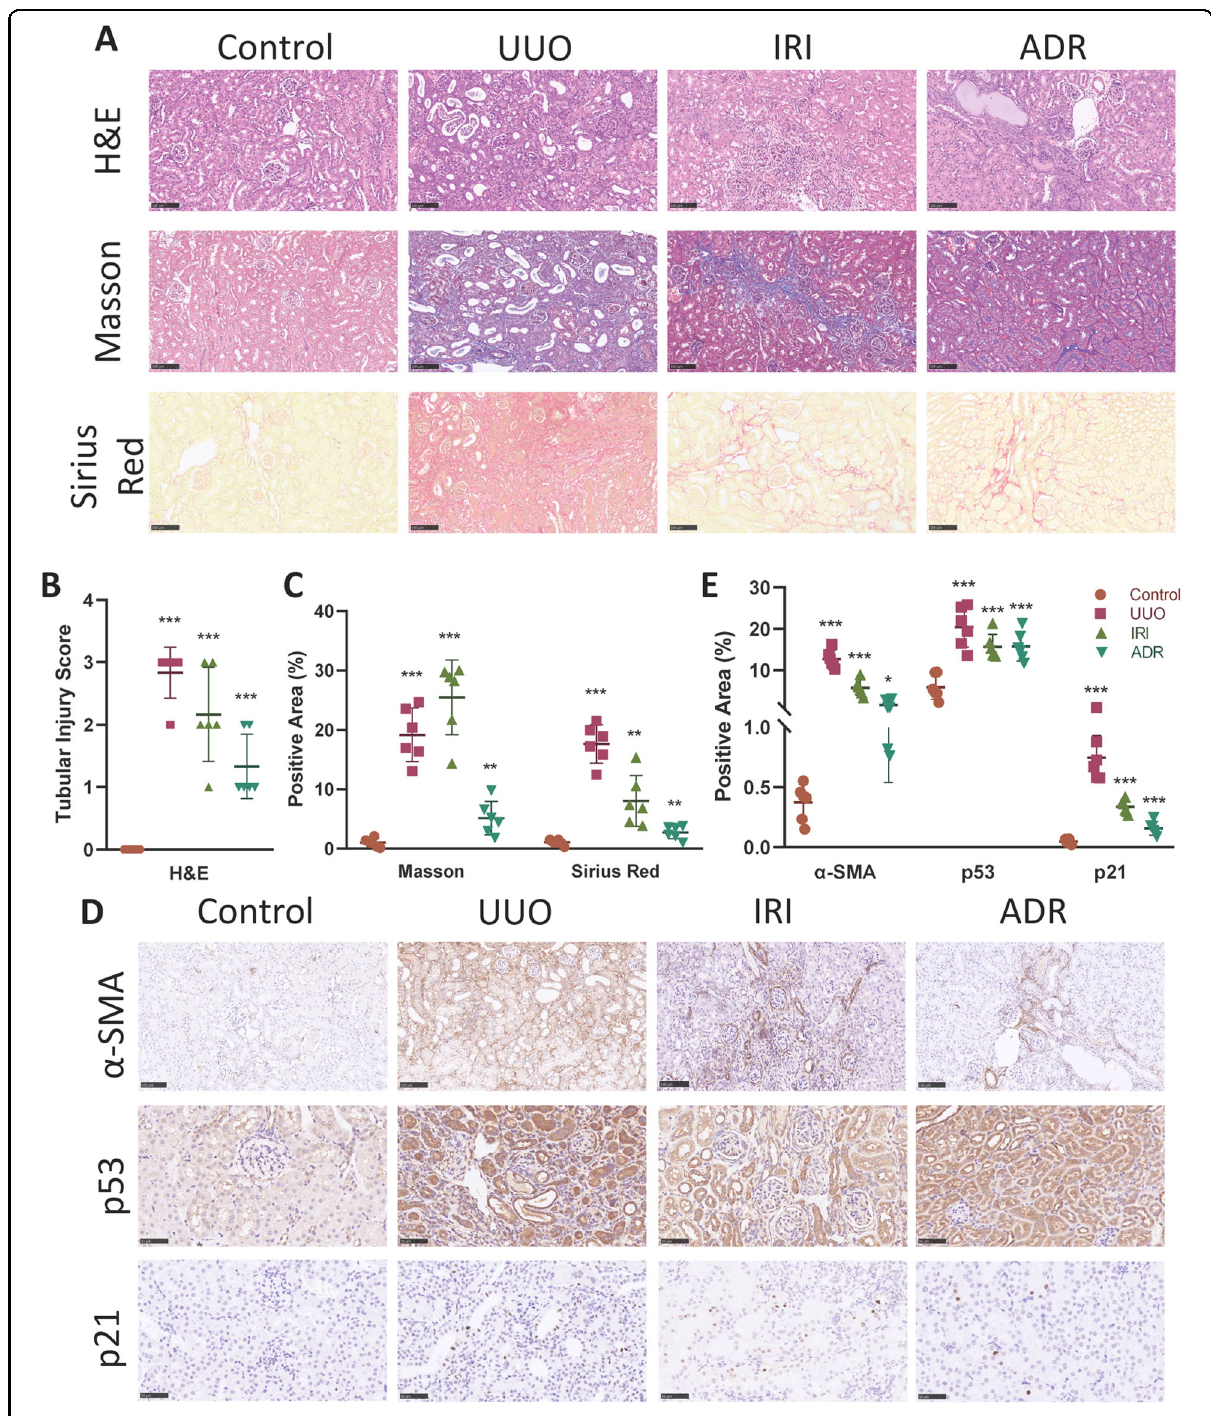
Fig. 2 α -SMA and p53 – p21 axis are upregulated in UUO, IRI, and ADR nephropathy models. A H&E, Masson trichrome, and Sirius red staining of control, UUO, IRI, and ADR nephropathy kidneys. Scale bar = 100 μ m. B Quantitative tubular injury scores of different groups assessed according to H&E staining. C Quanti fi cation of Masson trichrome and Sirius staining in different groups. D Immunohistochemistry staining of α -SMA, p53, and p21 in different groups and E their quanti fi cations. Scale bar = 100 μ m for α -SMA and scale bar = 50 μ m for p53 and p21. * P < 0.05; ** P < 0.01; *** P <